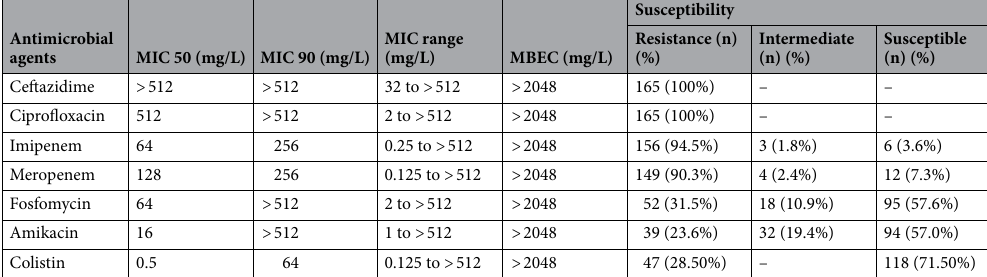
Table 1. Susceptibilities to different antibiotics among planktonic and biofilms of 165 carbapenem-resistant Klebsiella pneumoniae clinical isolates.